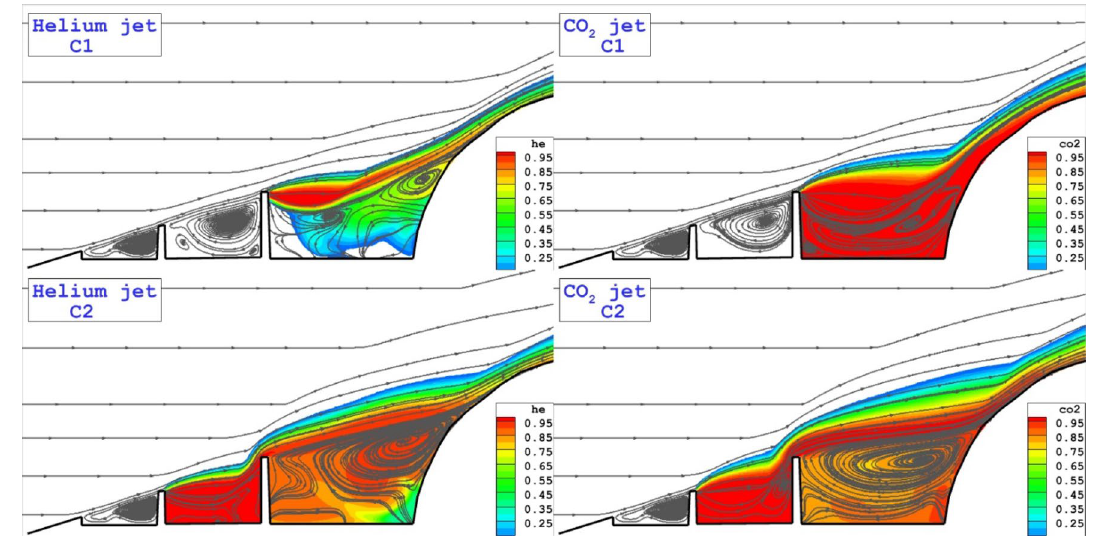
Figure 4. Comparison of the coolant mass fraction and flow stream for the injection system from the tip of disks.